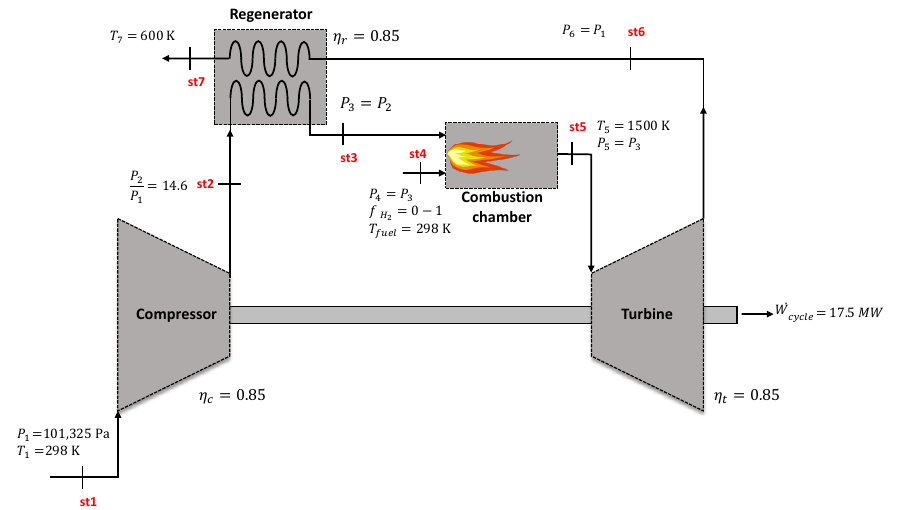
Figure 2. Schematic view of the regenerative Brayton cycle indicating the I/O